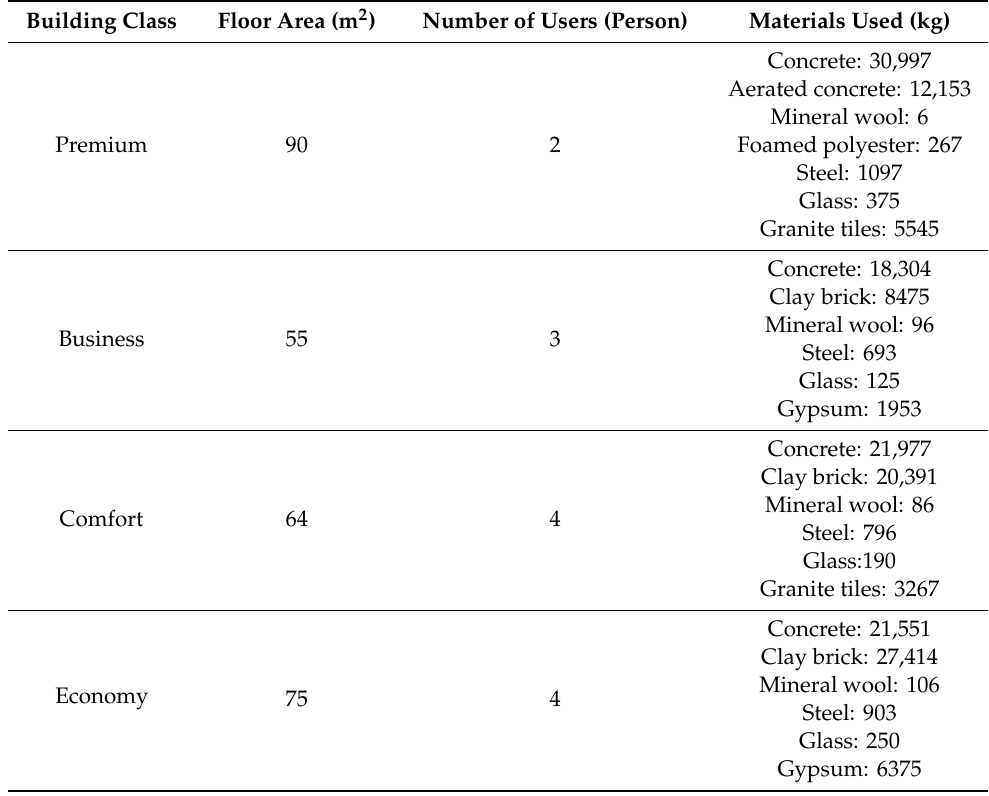
Table 1. Key parameters and estimations.